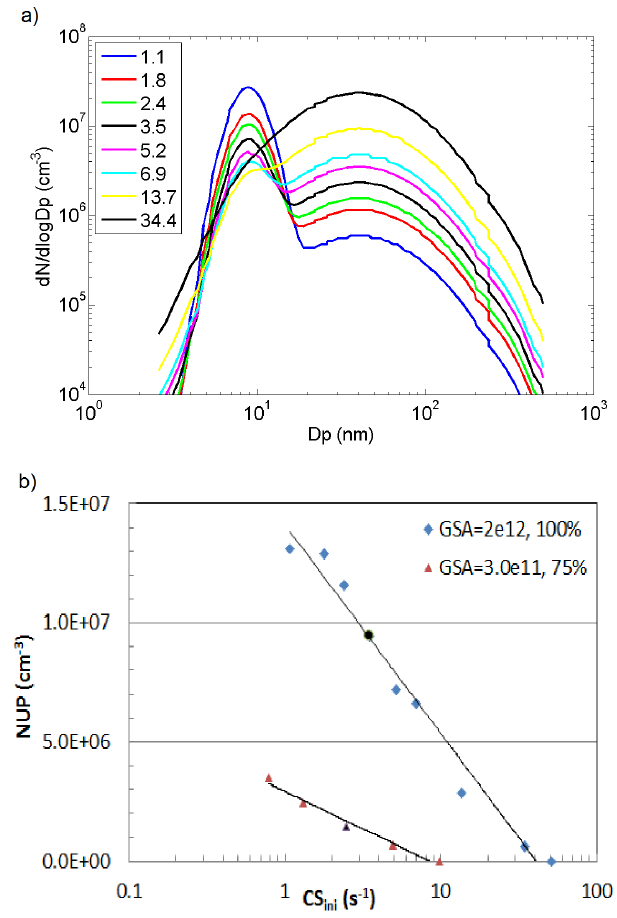
Figure 10. (a) Initial soot and core mode concentrations. The leg- end shows the corresponding condensation sinks in s − 1 . (b) Nucle- ated particle concentration (NUP) at the end of the simulation as a function of initial condensation sink for 100% engine load with GSA = 2 × 10 12 cm − 3 and raw exhaust T = 697K. Also shown in (b) are the results for 75% engine load with GSA = 3 × 10 11 cm − 3 and raw exhaust T = 657K. Black dots refer to base cases.